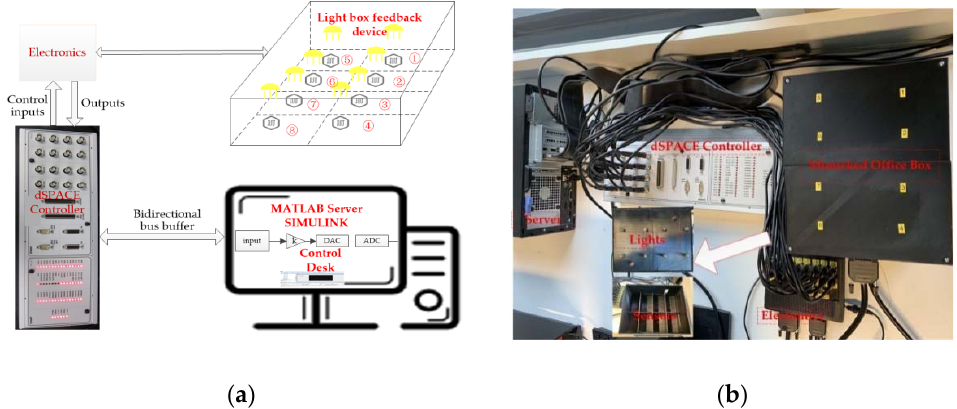
Figure 1. Multiple lighting control system based on dSPACE: ( a ) system block diagram; ( b ) real system (picture).